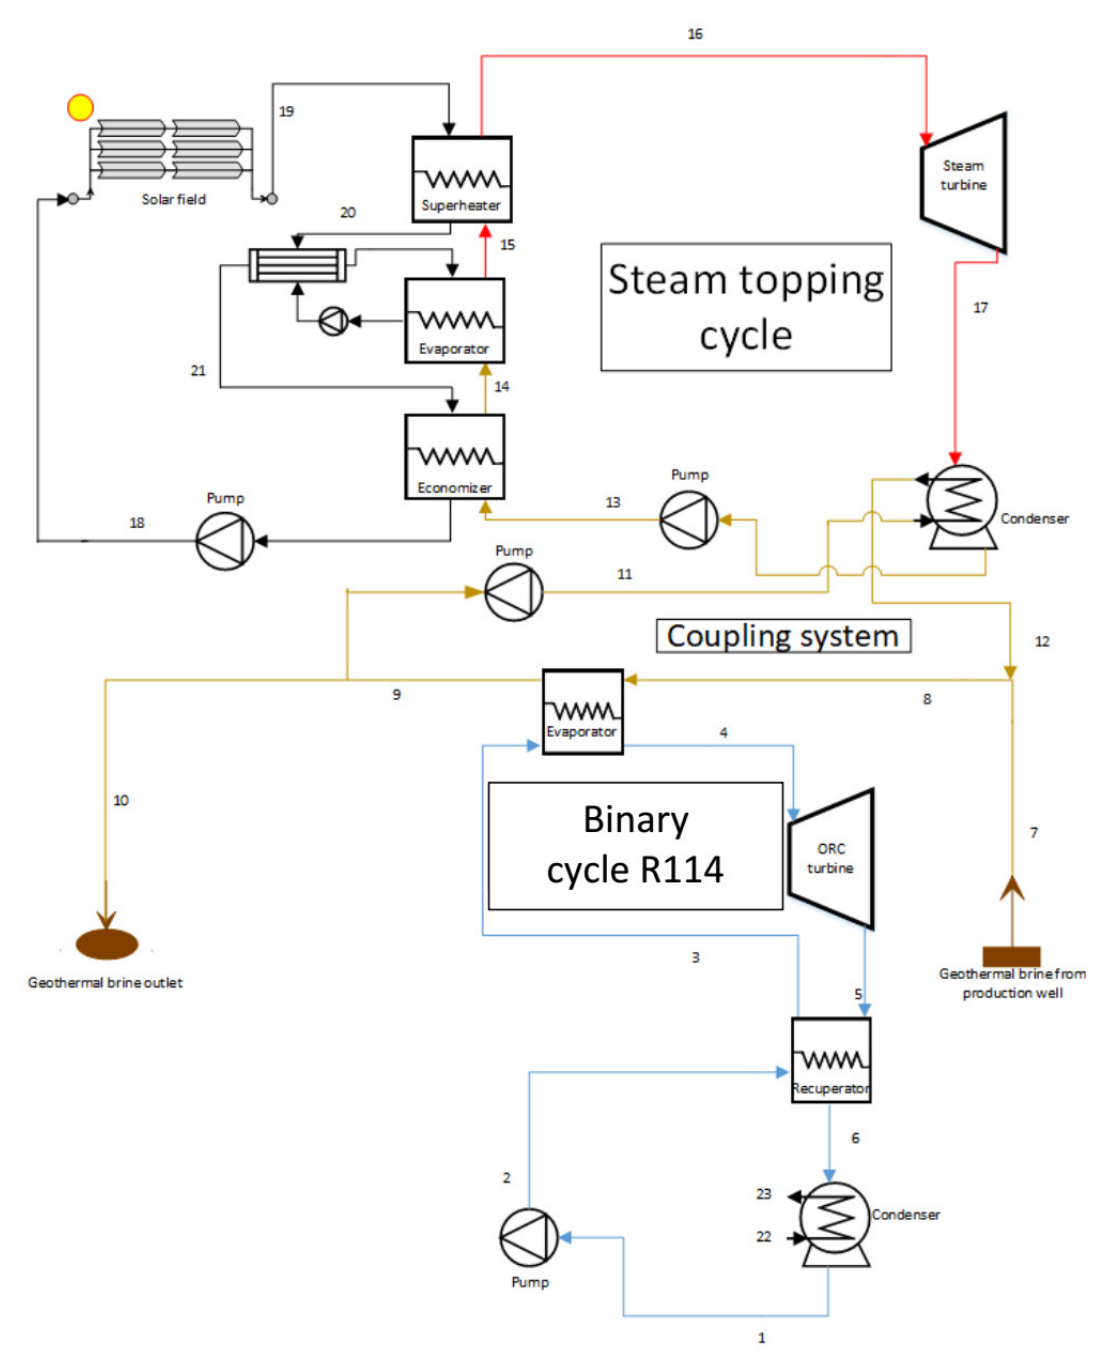
Figure 1. Integrated geothermal – solar Rankin cycle.